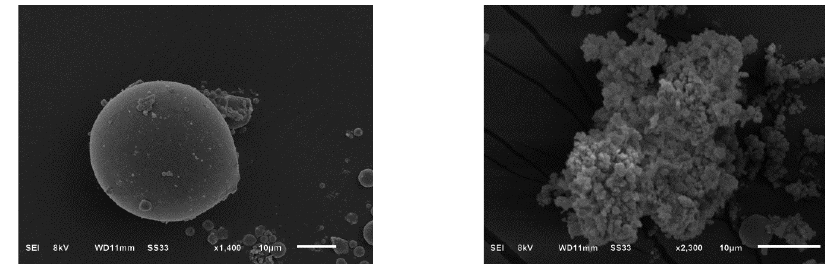
Figure 4. Particle morphology of fly ash ( left ) and amidoxime modified polyacrylonitrile/fly ash composite ( right ) demonstrated by SEM graphs.